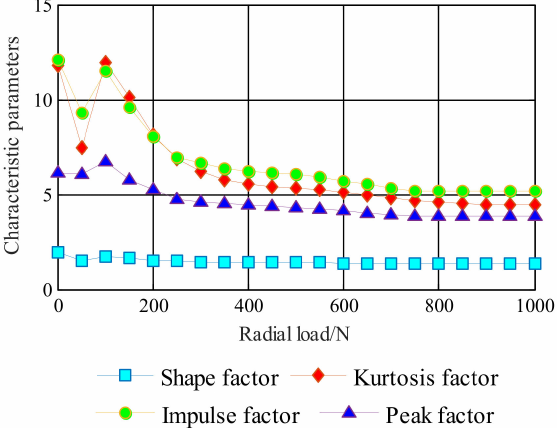
Figure 25. Influence of the radial load on dimensionless CP.